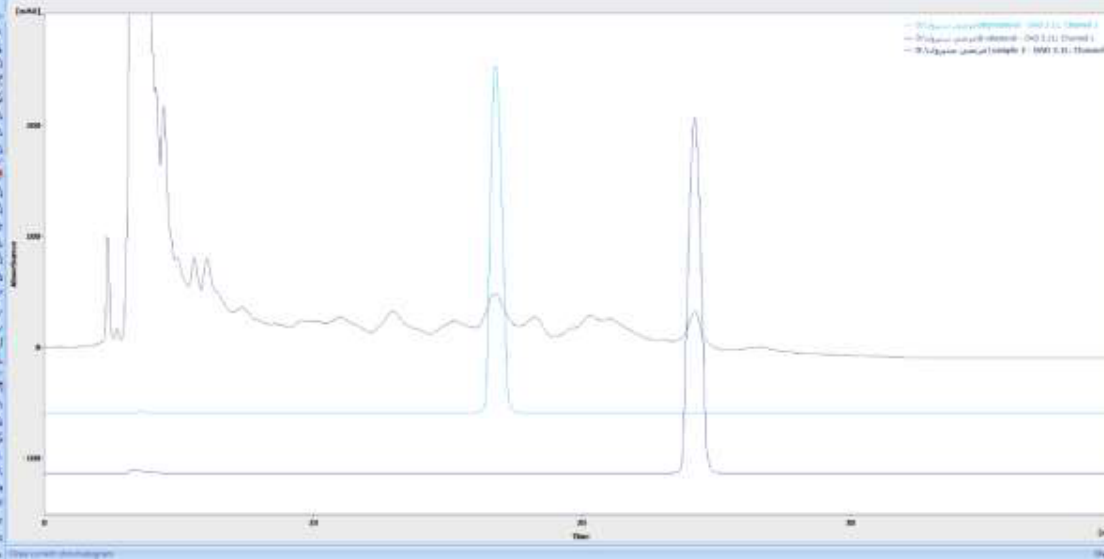
Figure 5. HPLC chromatogram analysis fractions contain β‐sitosterol and stigmasterol(sample, Standard). The retention time for isolated compound & β‐sitosterol standard is identical